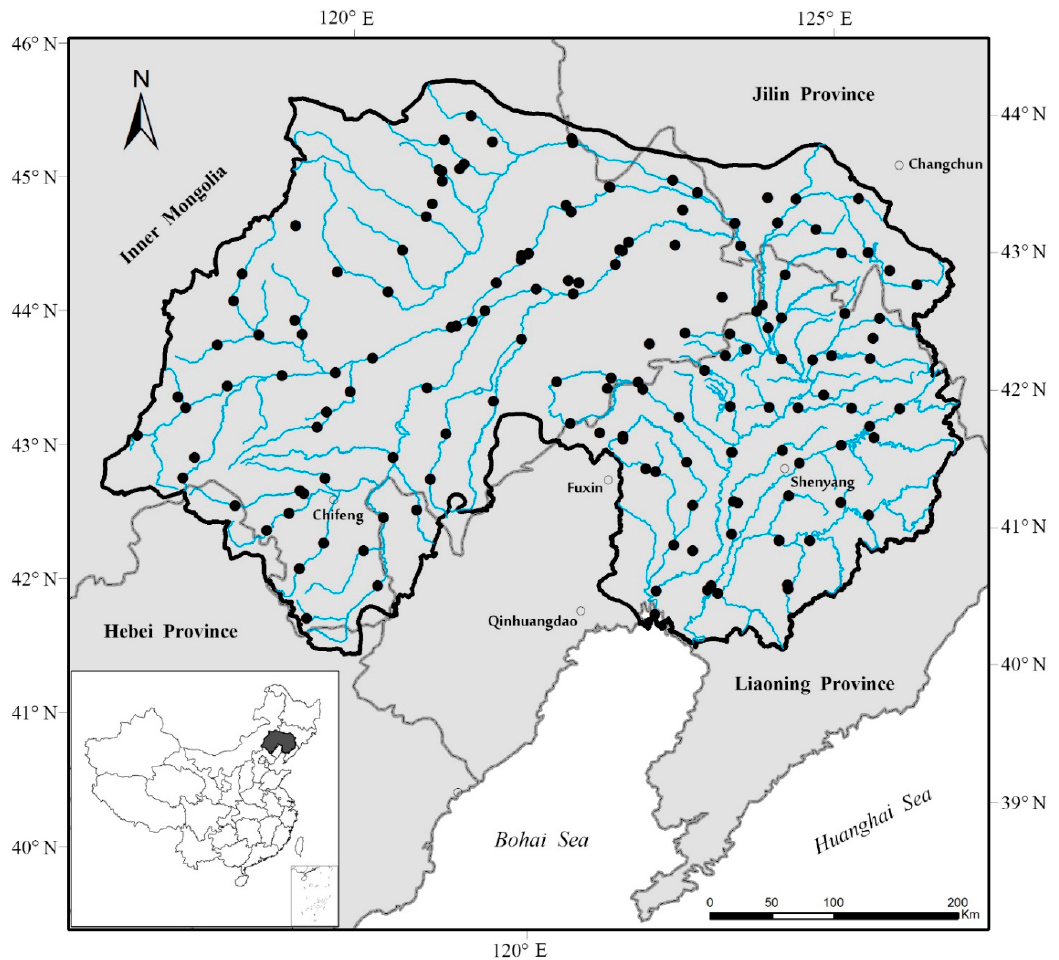
Figure 1. Location of the study sites in the Liao River Basin in Northeast China. (black line: boundary of the Liao River Basin; filled circle: sampling sites; blue line: main streams; gray line: boundary of provinces).